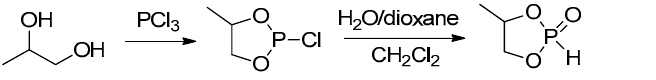
Scheme 10. Synthesis of 4-methyl-2-oxo-2-hydro-1,3,2-dioxaphosphol